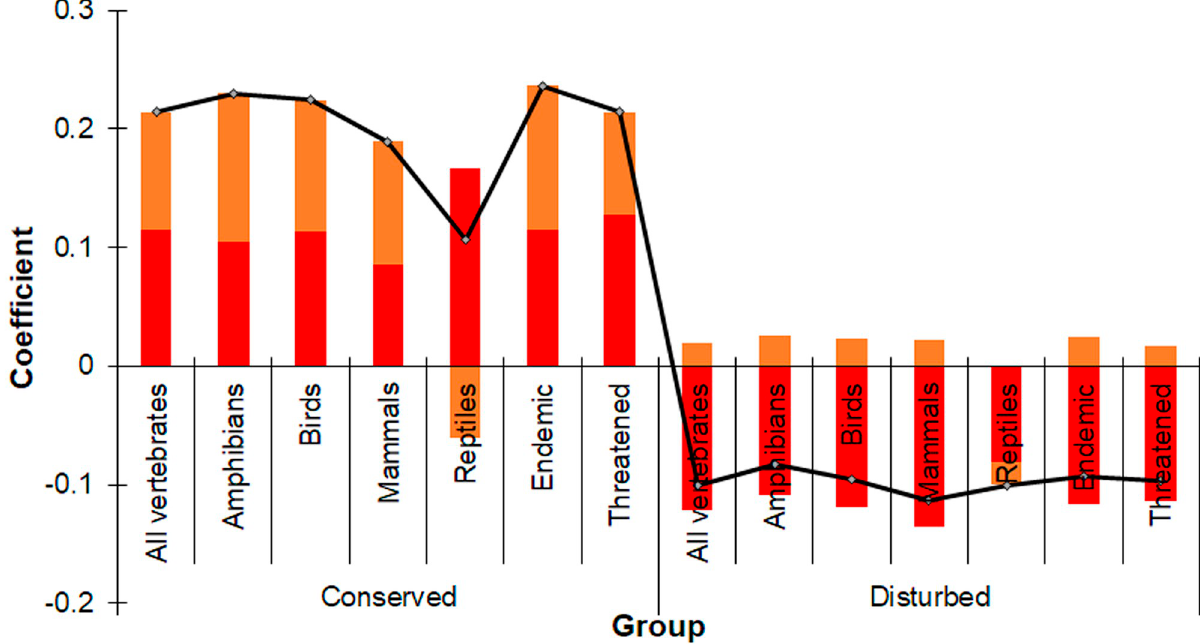
Fig 9. Path analyses of the total correlation coefficients (black line) composed of direct effects of vegetation (red bars) and the indirect effects of elevation (orange bars) in Colima, Mexico. The graph indicated the degree of correlation with land cover once the expected correlation with elevation is explained; positive values indicate positive correlation and negative values negative correlation.